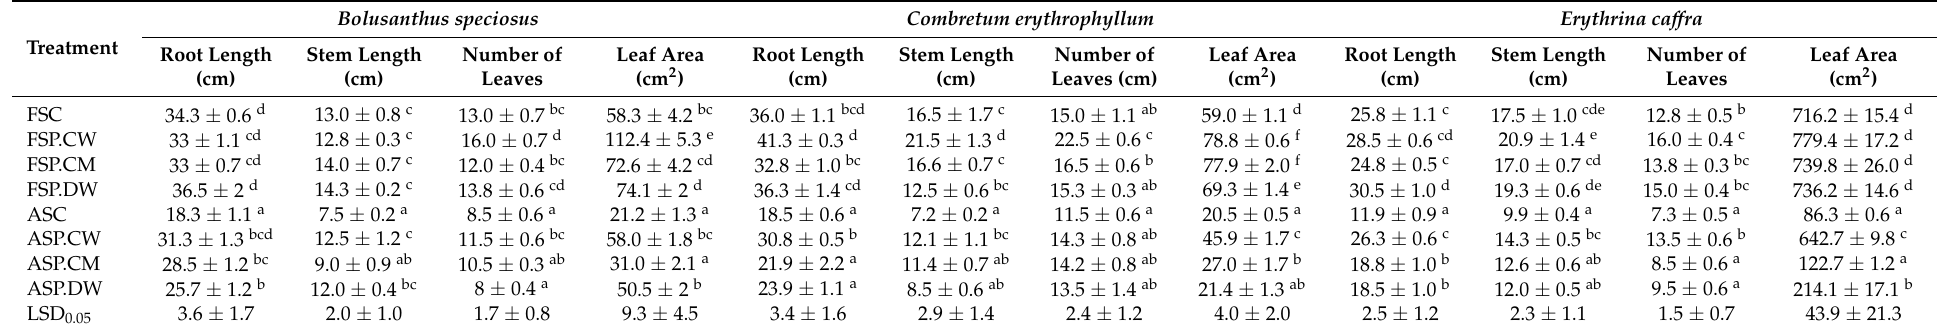
with deionized water. ANOVA was performed across treatments. Means of replicate were separated at LSD 0.05 . Post hoc was done using a Tukey test. Means along the same row with different letters were significantly different ( p < 0.05, n = 32). Table 2. Effects of cathodic water, calcium magnesium solution and deionized water treatments on the root length, stem length, number of leaves and leaf area of Bolusanthus speciosus, Combretum erythrophyllum and Erythrina caffra